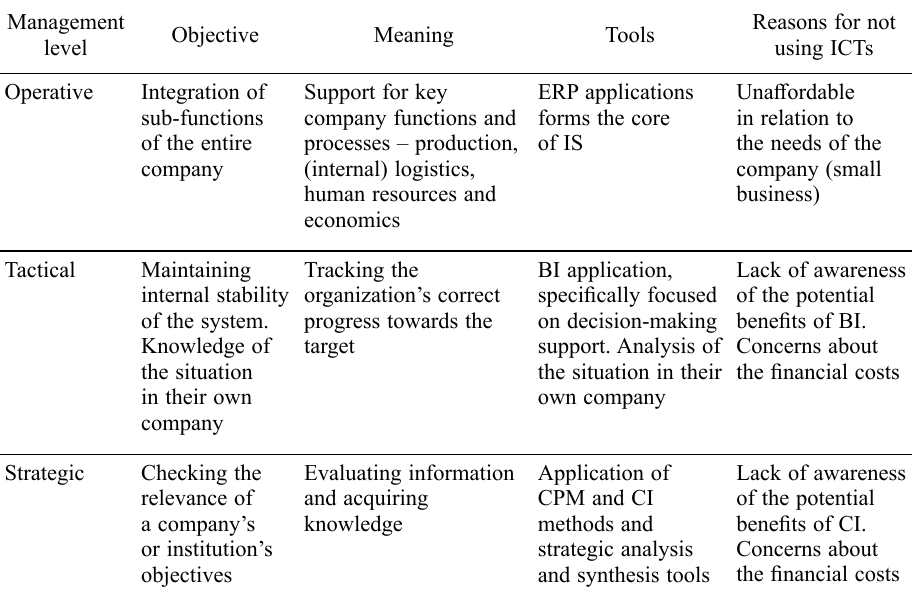
Table 1. The role of ISs and ICTs in management